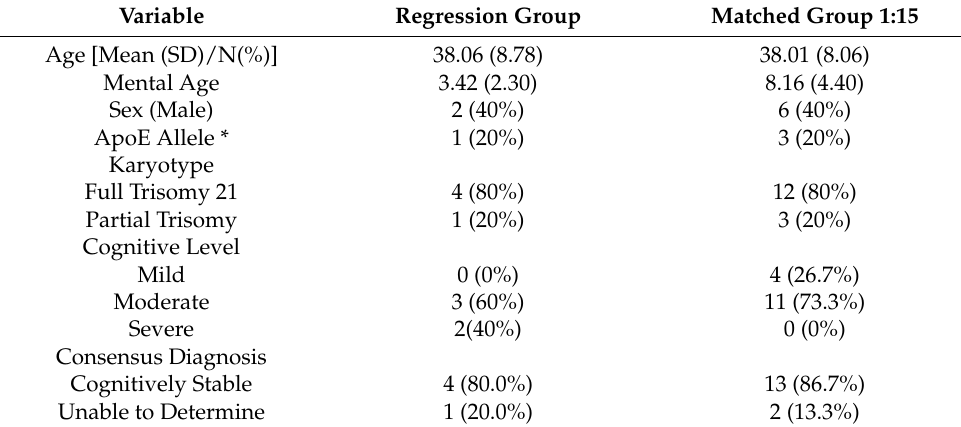
Table 2. Characteristics of regression and matched